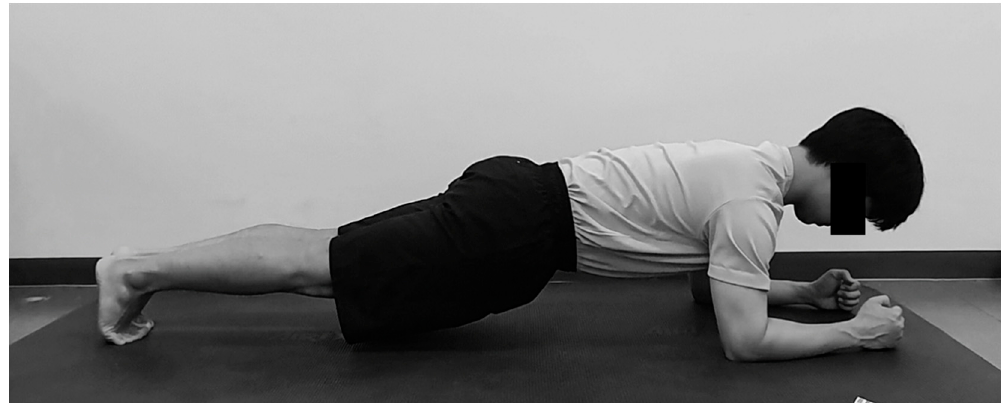
Figure 4. Elbow-toe exercise. Figure 4. Elbow-toe